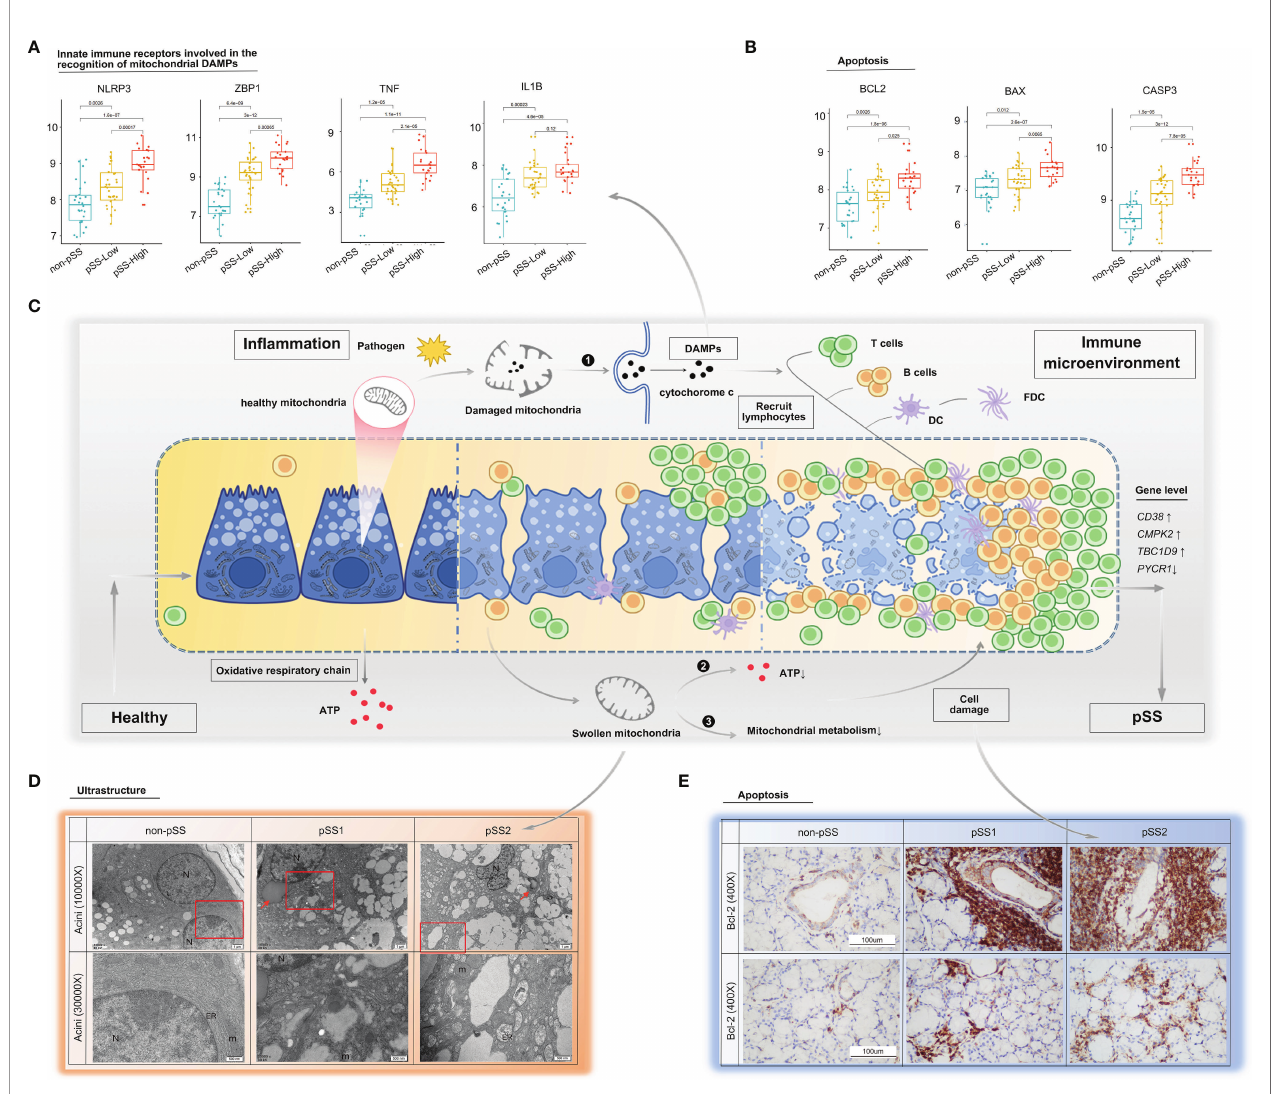
FIGURE 6 | Mitochondria as a possible link between in fl ammation and immune microenvironment in pSS. (A, B) Differential gene expression analysis of damage- associated molecular patterns (A) and apoptosis (B) was conducted using the ggpubr package via the Wilcox test from the validation cohort. (C) Schematic diagram describing possible mechanisms on how mitochondria act as a bridge between in fl ammation and immune microenvironment in pSS. The in fl ammatory environment in salivary glands of pSS initiated by a multitude of promising factors, including pathogen, which can indirectly or directly cause mitochondrial dysfunction. ( ❶ Once cell damages, some molecules, such as cytochrome c, carried by mitochondria will be released into inappropriate compartments and serve as DAMPs, recognized by immune cells, and trigger immune responses; ❷ impaired fi ve mitochondrial respiratory-chain complexes had reduced ATP production level through OXPHOS, which often lead to aggravated cell damage; and ❸ damaged mitochondria had been associated with abnormal mitochondrial energy metabolism, and it might further compromise epithelia cell survival. Consequently, a vicious pathological circle is activated, consisting of DAMP release, massive immune cell in fi ltration, and mitochondrial damage.) DAMPs: damage-associated molecular patterns, OXPHOS: oxidative phosphorylation system. (D) TEM of labial salivary gland tissue from our own cohort shows cytoplasmic lipid droplets (red arrows) and progressive swollen mitochondria in salivary epithelial cells as disease progress (red frame). (E) Immunohistochemical staining for Bcl-2 of paraf fi n-embedded labial salivary gland specimens. Scale bar = 100 m